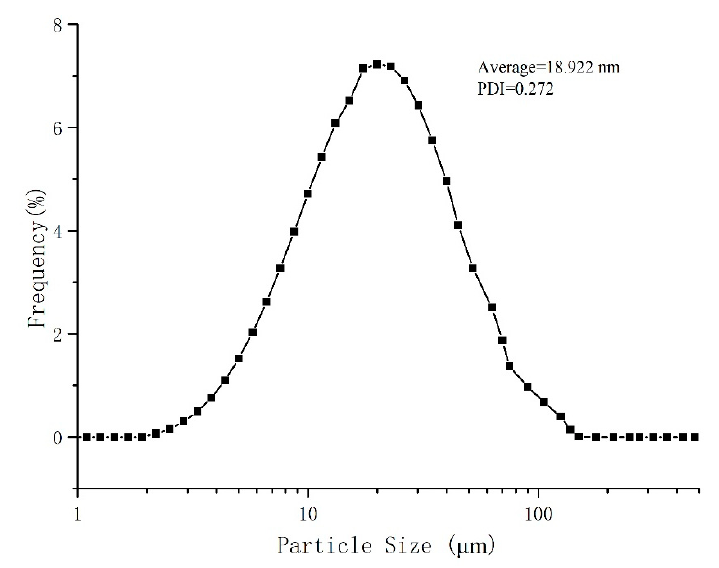
Figure 3. Particle size of the spray-dried microcapsules.